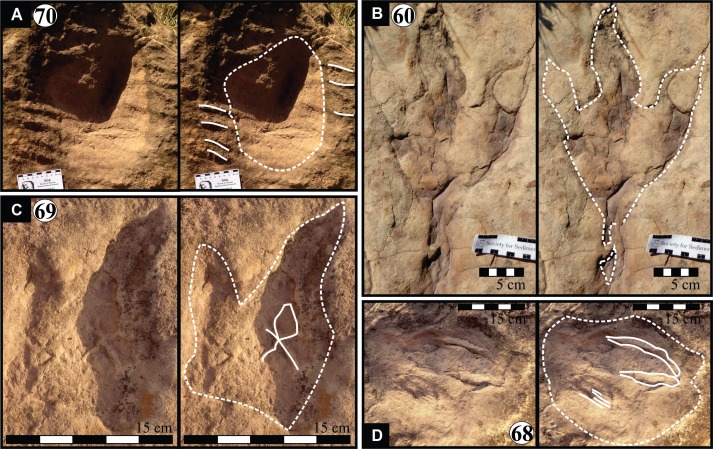
Isolated modified true tracks.(A) Track #70 is covered by well-preserved asymmetrical ripple marks (height: <1 cm; wavelength: 1.6 cm) indicate that a unidirectional water current gently washed over the palaeosurface after the track was made. (B) Track #60 is associated with a poorly preserved impression of the metatarsal. Note the claw marks on all three digits. (C) Track #69 is a true track in spite its amorphous morphology and preserves casts of desiccation cracks indicative of subaerial exposure subsequent to track formation in a moist substrate. (D) Track #68 illustrates how the wet pliable, plastic sediment was squeezed between the digits and collapsed around the track resulting in an indistinct, amorphous morphology. Ridges in the impression of digit IV probably resulted from the accidental skidding of the animal’s foot over a water-saturated sandy substrate (cf. Milàn, 2006).